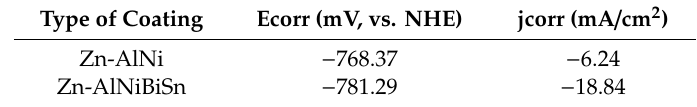
Table 4. Electrochemical corrosion parameters of the tested coatings in a 3.5% NaCl